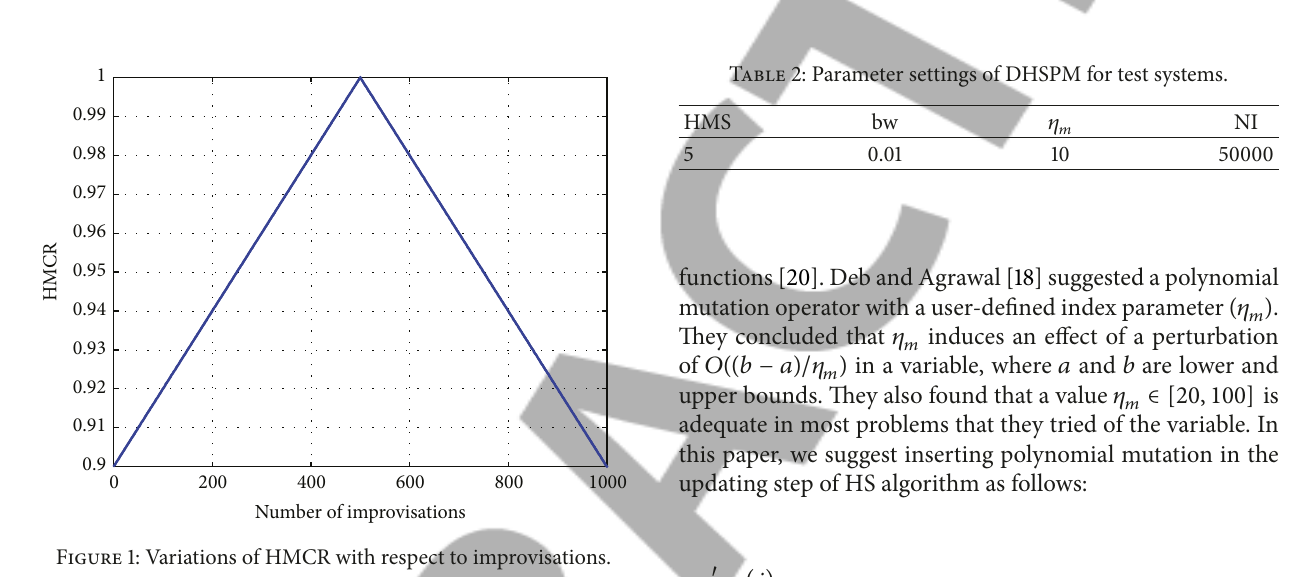
Table 2: Parameter settings of DHSPM for test